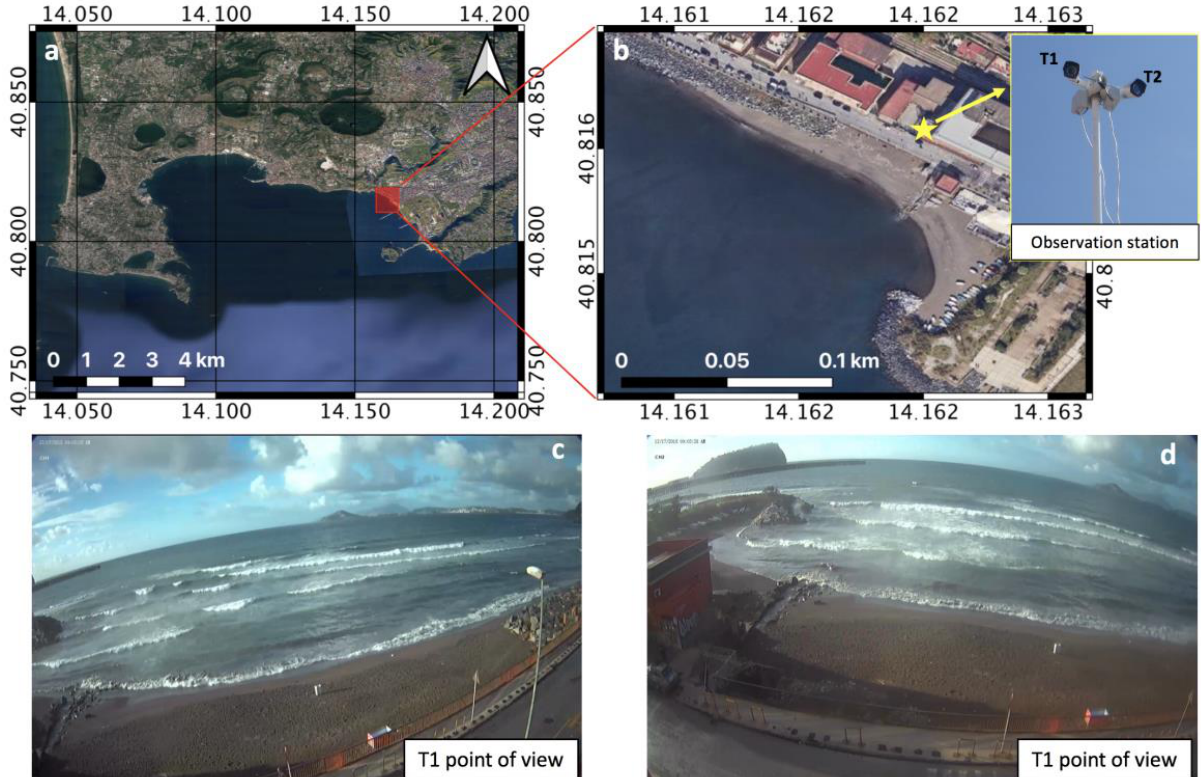
Figure 1. Overview of the study area ( a ) and zoomed-in image of the investigated beach ( b ), showing the points of view of the video-monitoring system (camera T1 ( c ) and camera T2 ( d )).